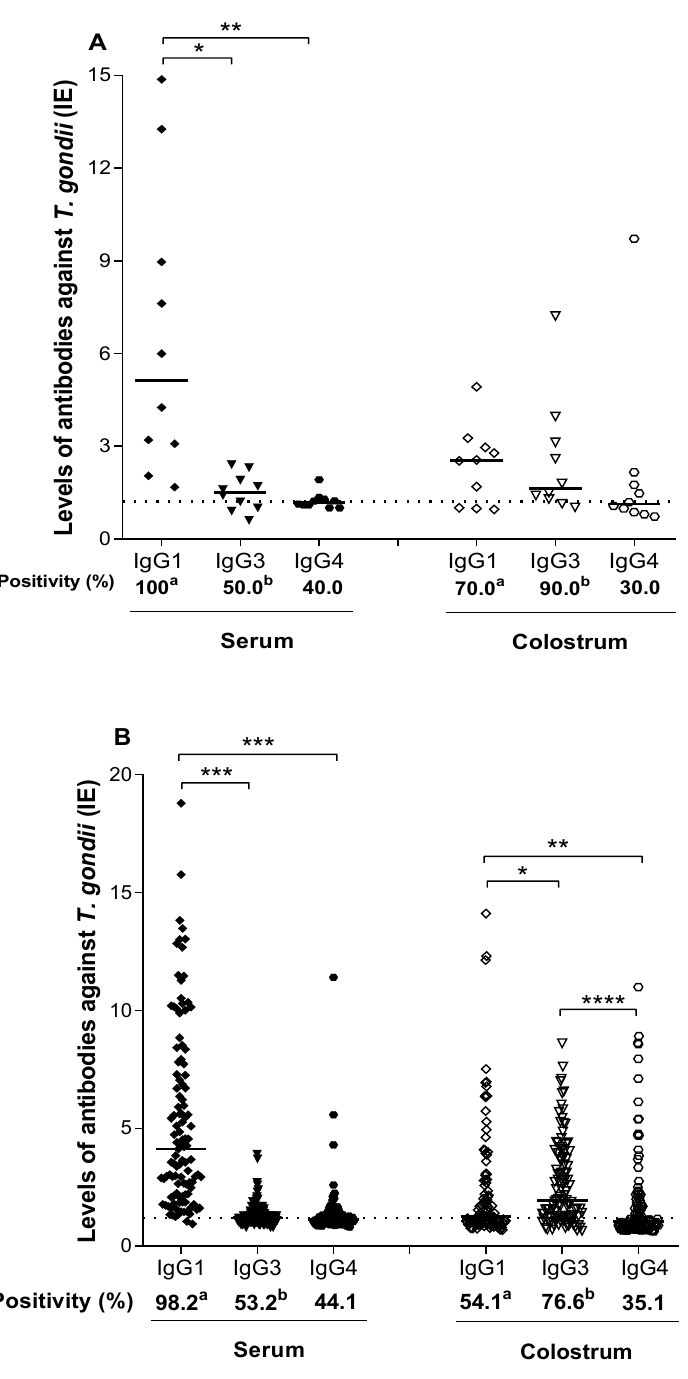
Figure 4. Levels of IgG1, IgG3, and IgG4 antibody subclasses against T. gondii in groups of paired samples. Data determined by ELISA index (IE), present in paired serum and colostrum samples. ( A ) Group II: levels of anti- T. gondii IgG1, IgG3, and IgG4 subclasses, of 10 samples from positive puerperal women for IgG and IgM antibodies specific to T. gondii . ( B ) Group III: levels of anti- T. gondii IgG1, IgG3, and IgG4 subclasses, in samples from 111 puerperal women with chronic toxoplasmosis. The dashed line represents the cut-off value (EI = 1.2). The solid lines represent the values of EI medians for each reaction. Differences between EI levels were calculated by Dunn’s multiple comparison test (* p < 0.05; ** p < 0.01; *** p < 0.001; **** p < 0.0001. The differences between the levels of positivity (%) (a and b) of the samples were calculated using Fisher’s exact test. Equal letters indicate significance ( p <